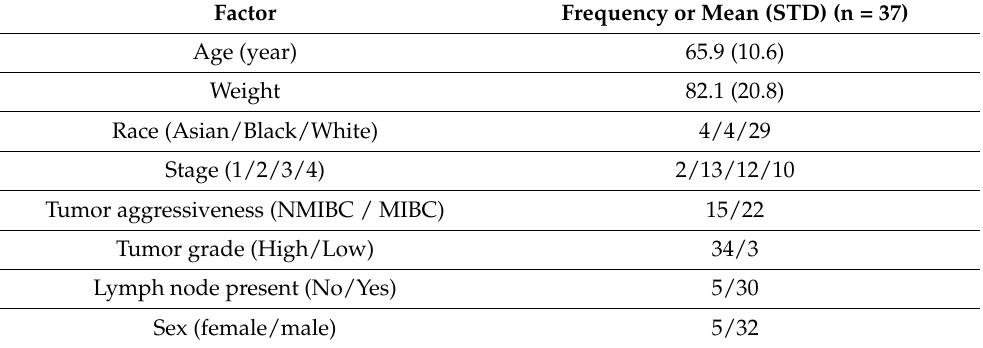
Table 4. The results of univariate analysis demonstrate that CDKN2A, CTSV, FOXM1 and KRT23 were predictive of tumor aggressiveness (MIBC) and the odds of having MIBC was increased by 3% per unit increase of CDKN2Aa (p = 0.01). The interpretation of other gene expressions remains similar. In addition, CDC20 values were predictive of OS ( p =